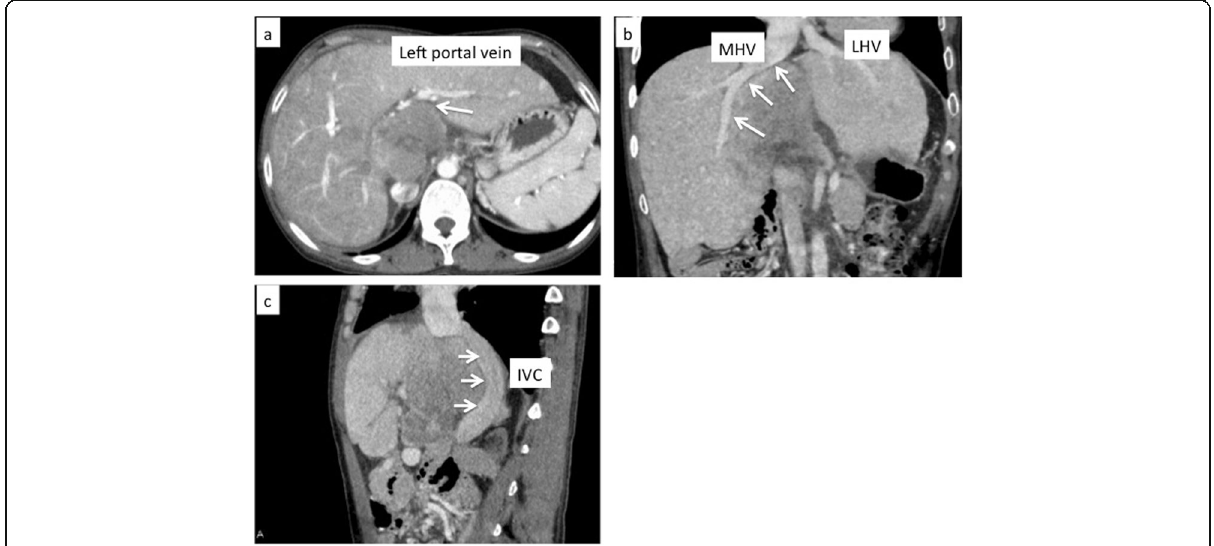
Fig. 2 Computed tomography showed a tumor attached to left portal vein ( a ). The tumor also attached to middle hepatic vein (MHV) ( b ) and inferior vena cava (IVC) ( c